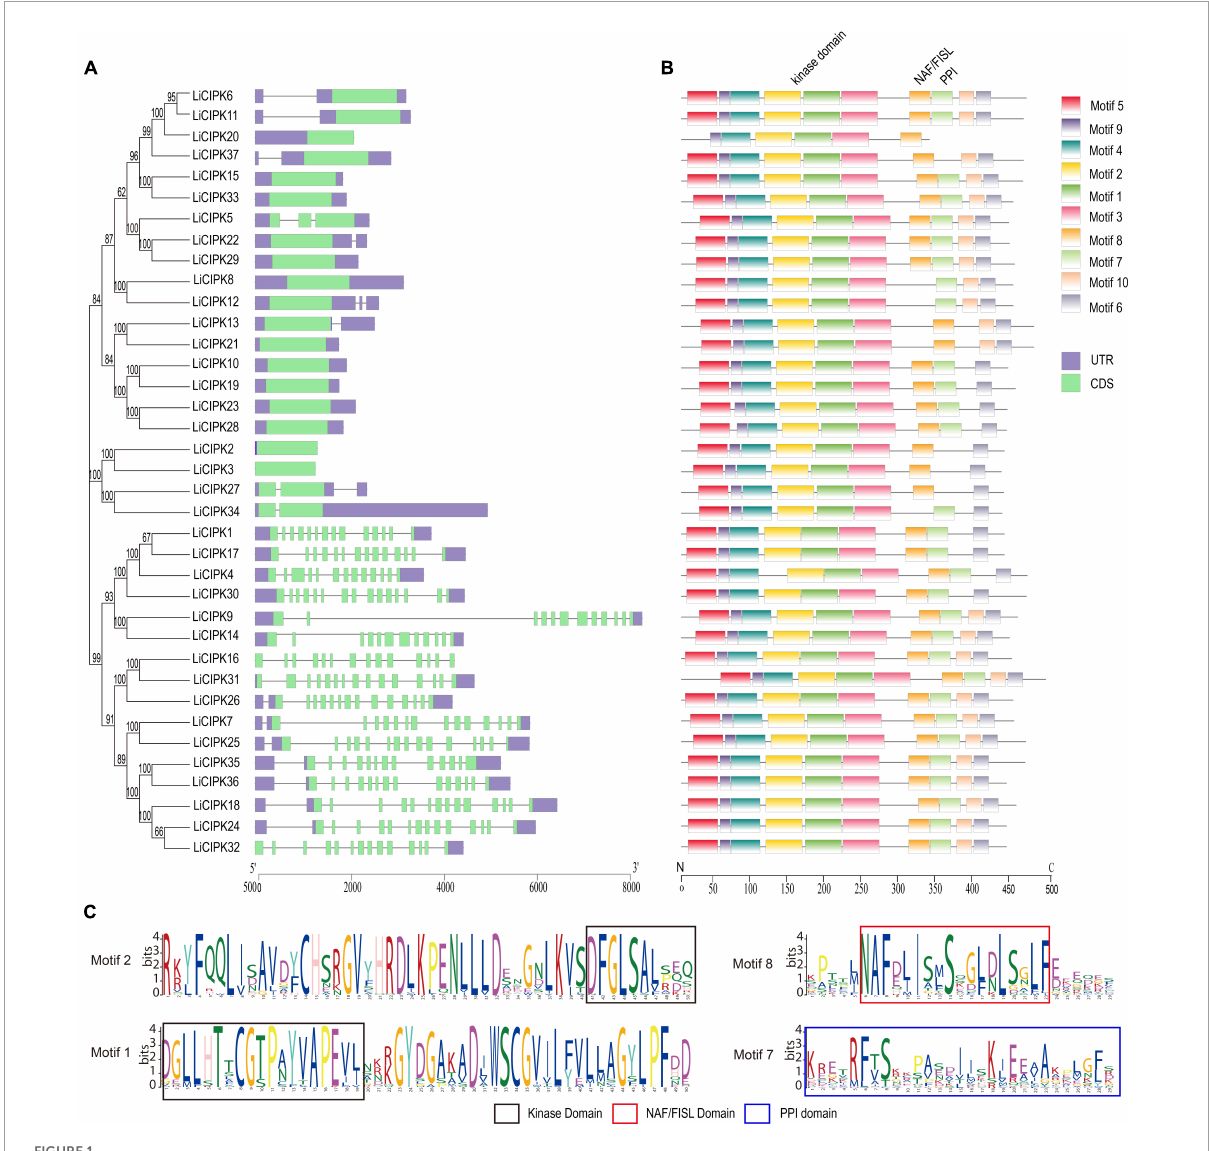
FIGURE1 Phylogenetic tree, conserved motifs, and gene structure of LiCIPKs . (A) Exon–intron patterns. (B) Conserved motifs arrangement of LiCIPKs. (C) The functional domains. Motifs and exons are indicated as rectangles, other sequences as